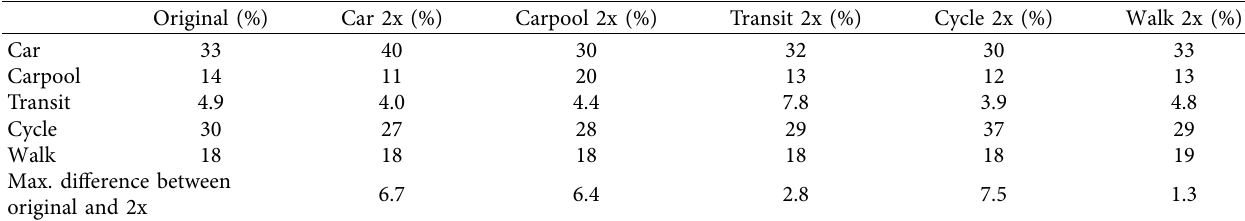
Table 7: Results modal split double mode (“red/blue bus paradox”).